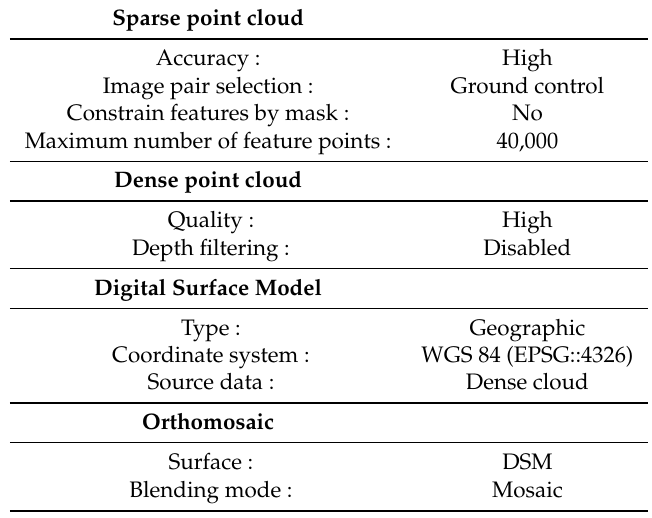
Table 1. The parameters used for the orthophotos building process in the Agisoft Metashape software. Sparse point cloud